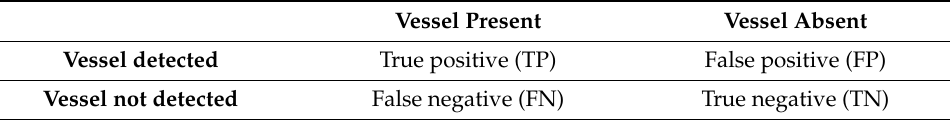
Table 1. Confusion matrix along with the adopted evaluation measures.